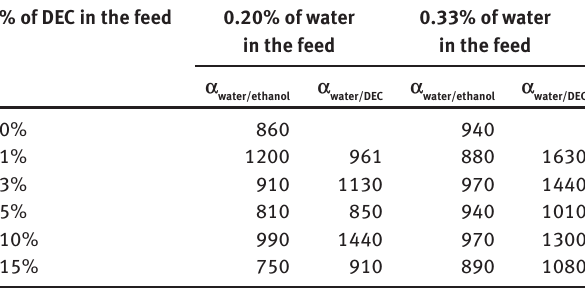
Table 3: Water selectivity as a function of ethanol and DEC for two amounts of water in the feed: 0.20 %wt and 0.33 %wt and different amounts of DEC: 0 %wt, 1 %wt and 3